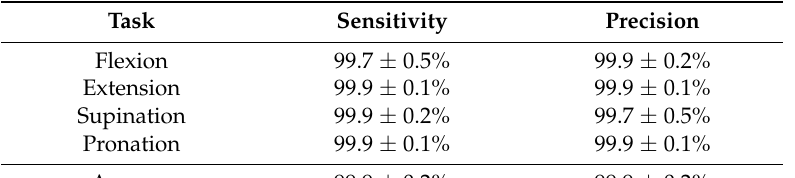
Table 1. Sensitivity and precision of identification of task using IMS features averaged between patients. Identification Indices for each patient were calculated as an average of hold-out repetitions (N = 20) and presented in terms of mean and standard deviation.